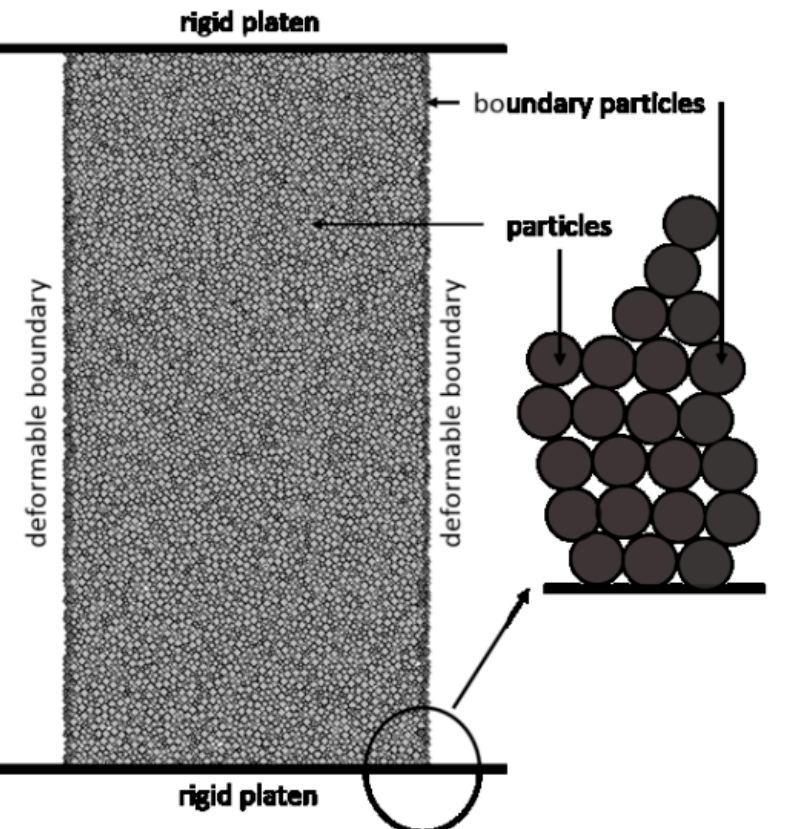
Figure 4. Particle size distribution.